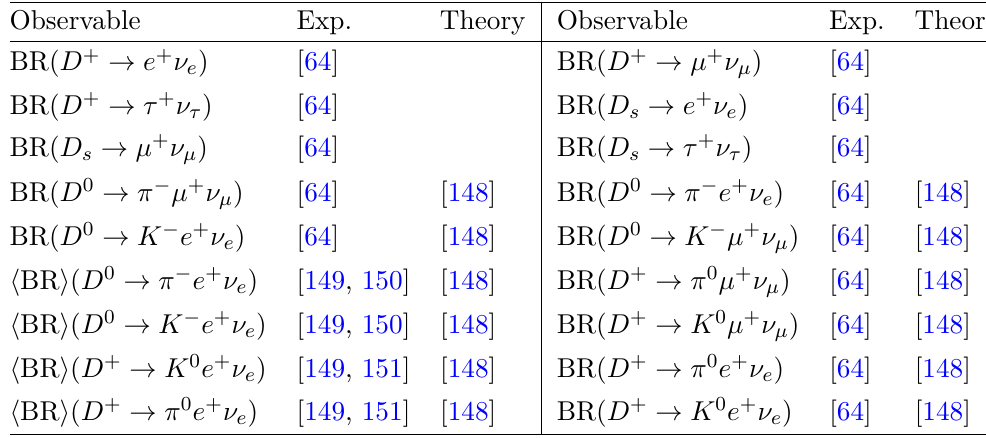
Table 8 . The D decay observables used in smelli , along with the relevant experimental measure- ments and theory papers used in the computation. h BR i are q 2 -binned branching ratios.